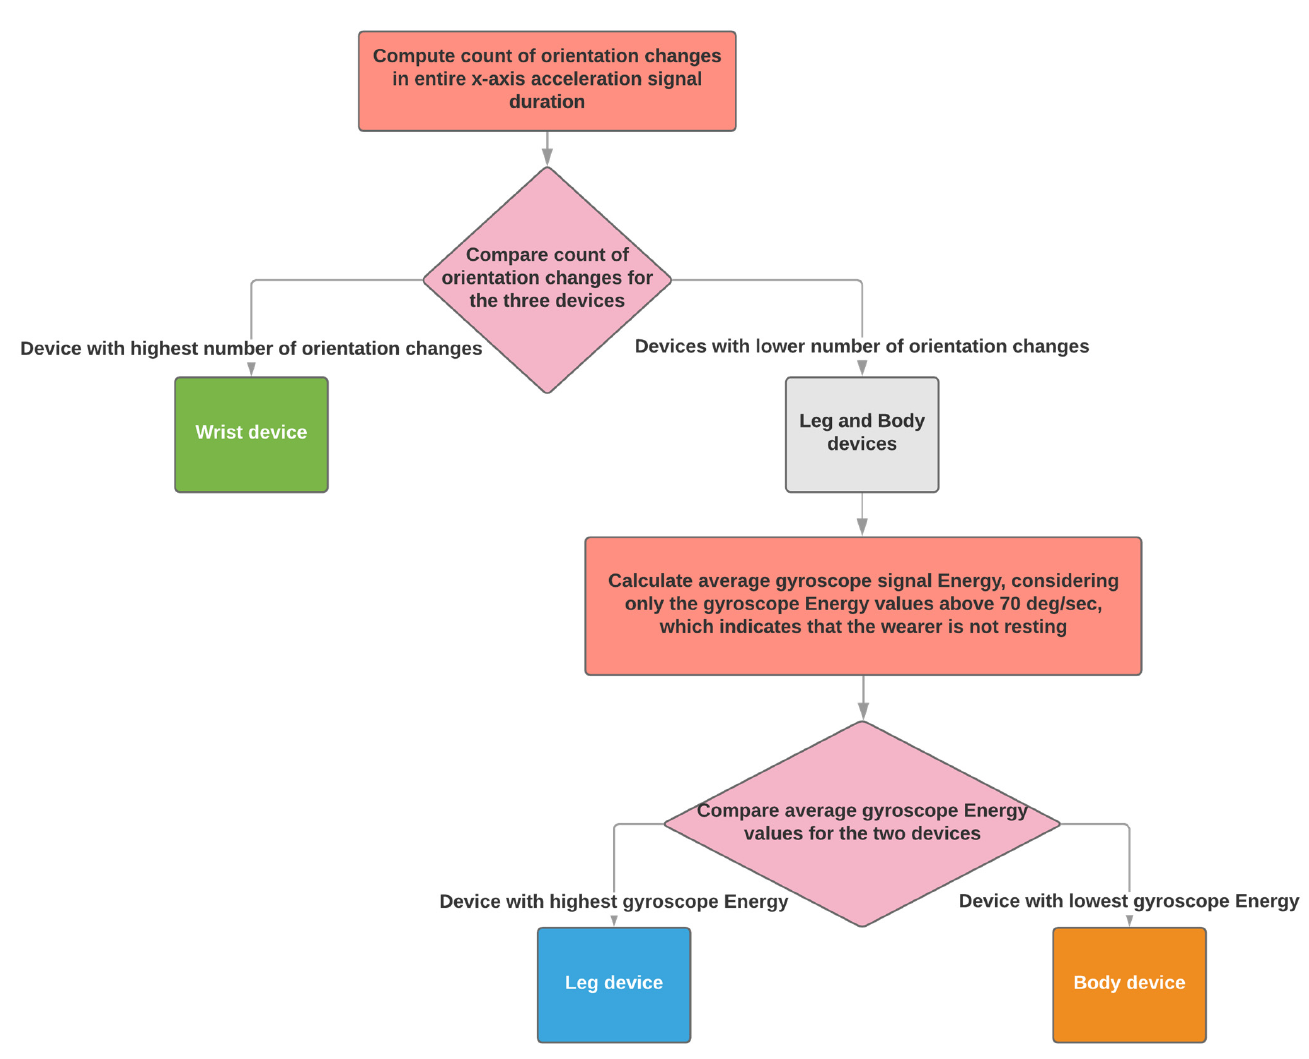
Figure 6. The automatic placement identification algorithm when three sensing devices have been used.